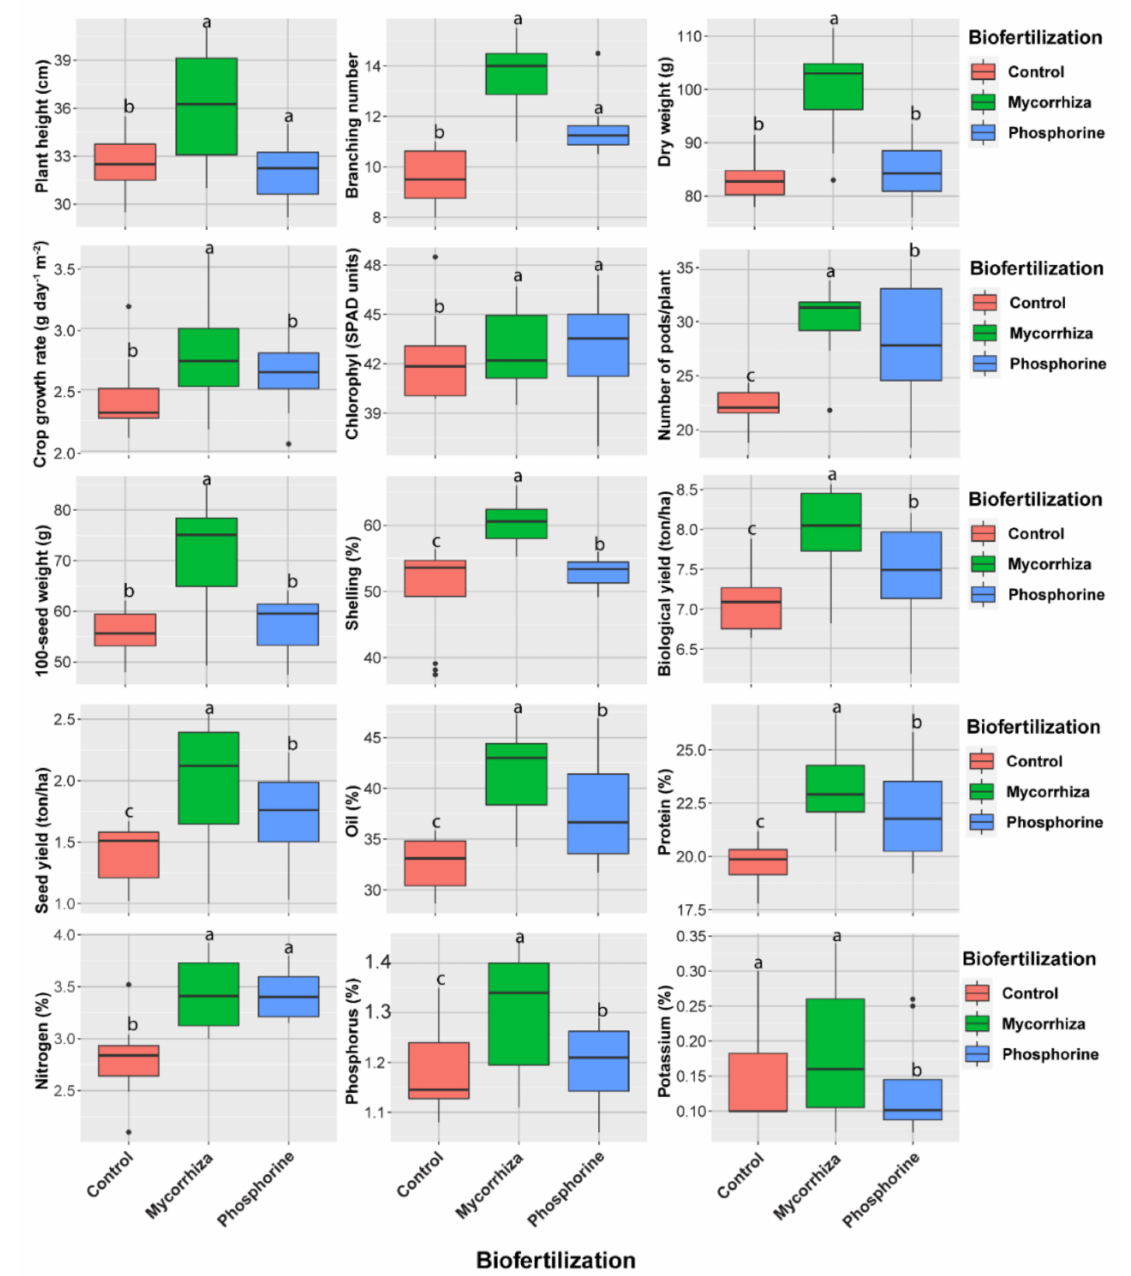
Figure 1. Effects of different biofertilization treatments (control, mycorrhiza, and phosphorine) on 15 studied traits for peanuts determined from the field experiments’ combined data from the 2020 and 2021 seasons. Different lowercase letters on error bars indicate statistically significant differences between treatments ( p ≤ 0.05), as performed by the least significant difference (Fisher’s LSD)